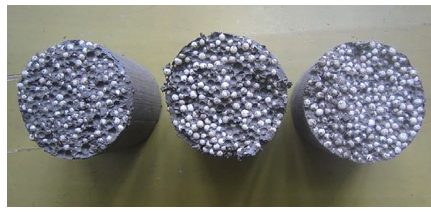
Figure 3: Cross sections of T11, T12, and